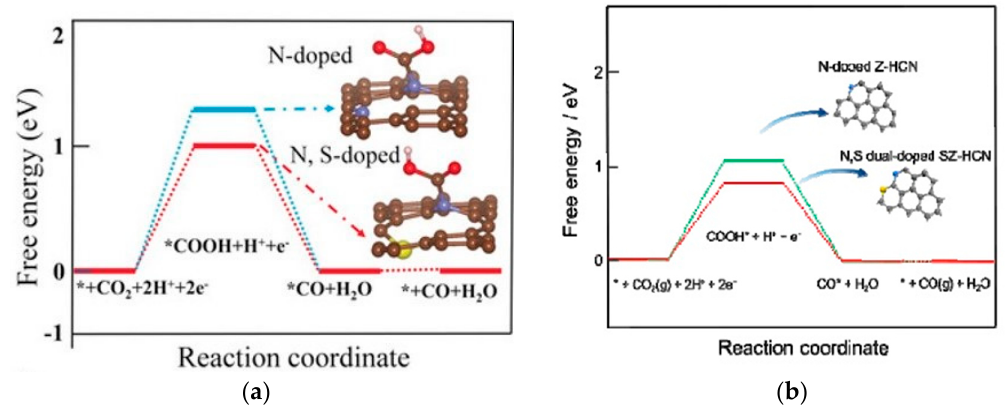
Figure 6. ( a ) Free energy diagram of CO 2 electrochemical reduction to CO on nitrogen-doped graphene and nitrogen, sulfur co-doped grapheme, reproduced from [111], Copyright (2020), with permission from John Wiley and Sons. ( b ) Free energy diagram of CO 2 reduction to CO on nitrogen-doped carbon hollow carbon nanospheres and nitrogen, sulfur co-doped hollow carbon nanospheres, reproduced from [112], Copyright (2020), with permission from Elsevier.